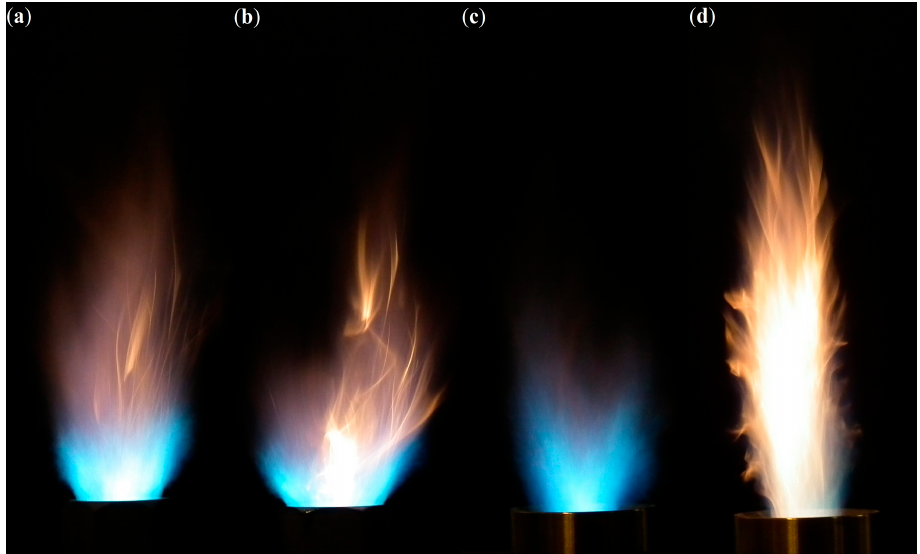
Figure 8. Flame images with various quarls. ( a ) 15° ( b ) 30° qualrs, showing attached flame to its wall. ( c ) 45° with detached flame in V-shaped mode and ( d ) straight flame also detached from the quarl wall.